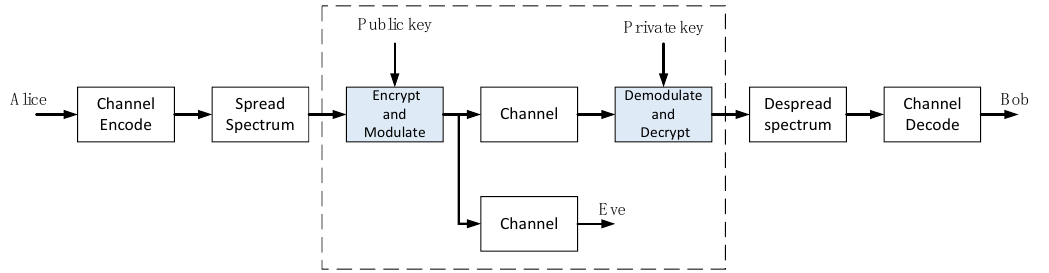
Figure 2. Block diagram of the encrypted communication system.